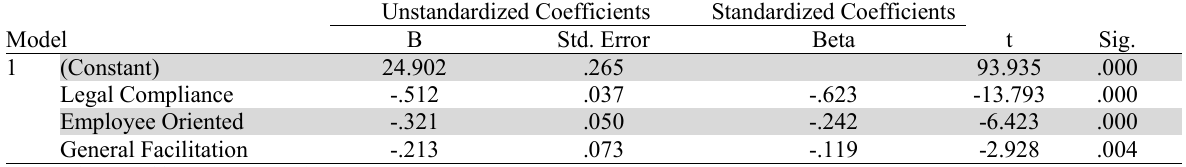
The results of regression analysis for model